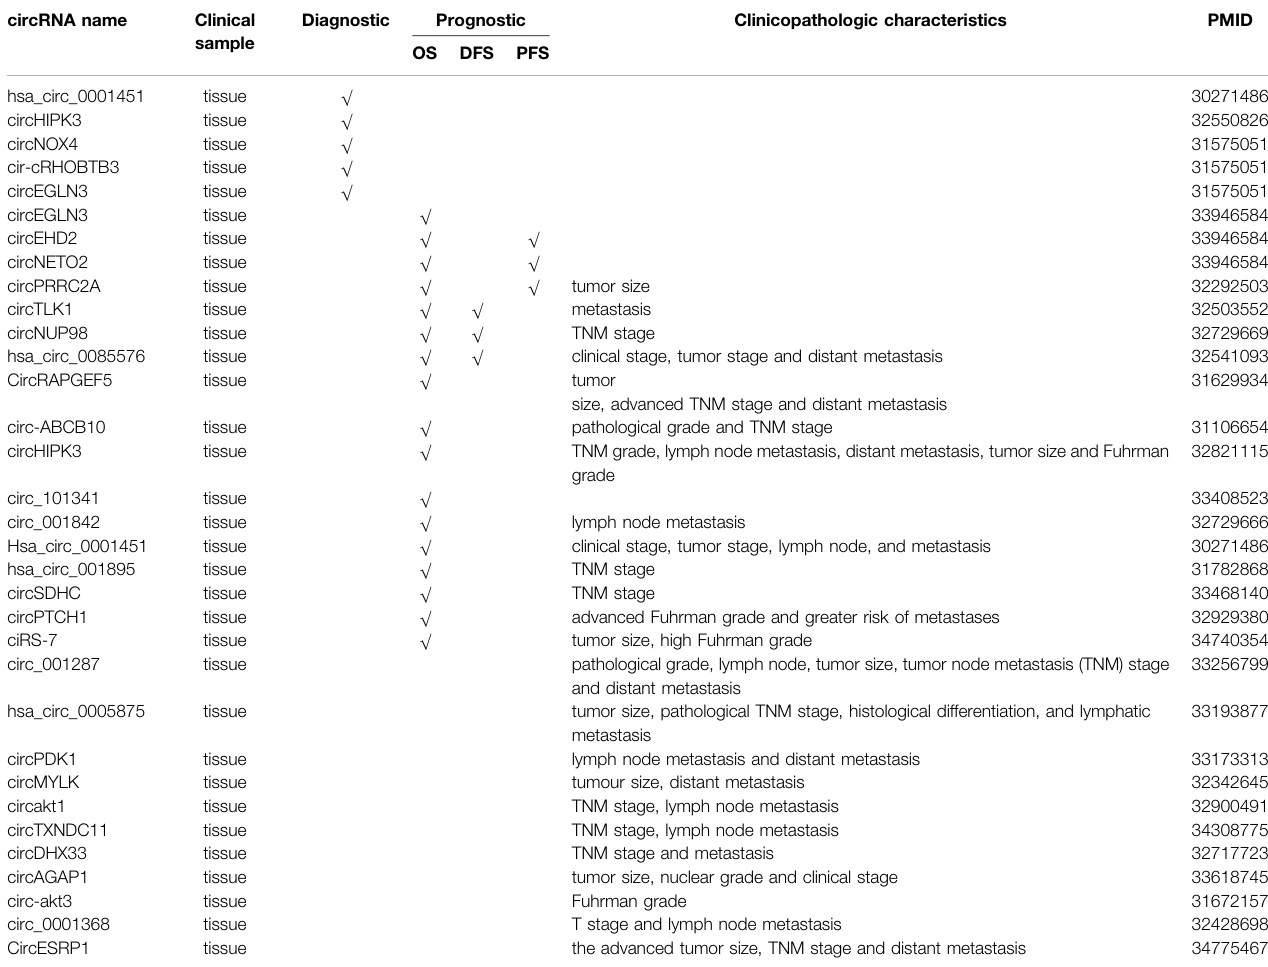
TABLE 2 | Utility of circRNAs for the clinical management of